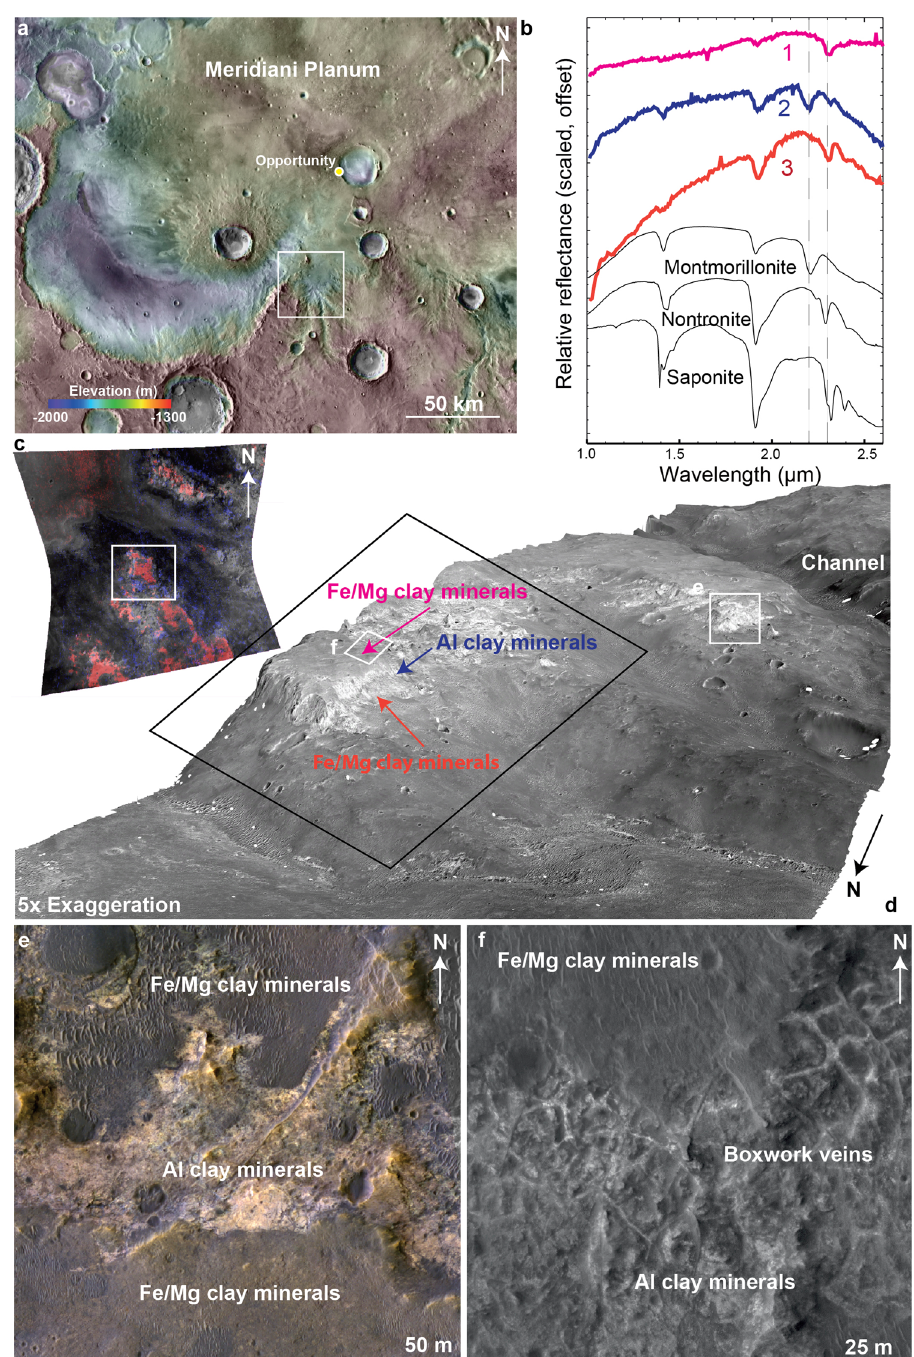
Fig. 5 Evidence of multiple pedogenic events in southern Meridiani Planum. a The geologic context of weathering pro fi les on an inter fl uve in southern Meridiani Planum. MOLA elevation data draped over THEMIS daytime infrared data (warm colors are higher elevation and cool colors are lower elevations). b CRISM data extracted from regions of interest are shown as offset ratio spectra compared to laboratory spectra of relevant minerals. c A CRISM mineral parameter map shows the distribution of Fe/Mg smectites and Al clay minerals (Fe/Mg smectites in red and Al clay minerals in blue). d 3D view of weathering outcrops is shown in the rectangle of c . with 5 times vertical exaggeration. The different color arrows show locations of spectra acquired. e Close-up view of HiRISE image shows the morphology and contact of clay-rich outcrops. f The subset of HiRISE images exhibits pervasive boxwork veins on the Al clay minerals ~200 m-thick deposit of layered sedimentary crater fi ll materials The upper unit has a broader asymmetric 2.20 μ m absorption, is younger, with a model age of ~3.18 Ga (Fig. 6c). Spectra of suggesting the presence of opaline silica or allophane/imogolite several chaotic outcrops, exhibit a top horizon of Al/Si-rich common in weathered volcanic ash 41 . The presence and deposits having a diagnostic absorption around 2.20 μ m over- preservation of amorphous materials imply a cold and water- laying Fe/Mg-rich smectites with a 2.30 μ m absorption feature. limited environment at that time 33,52 .